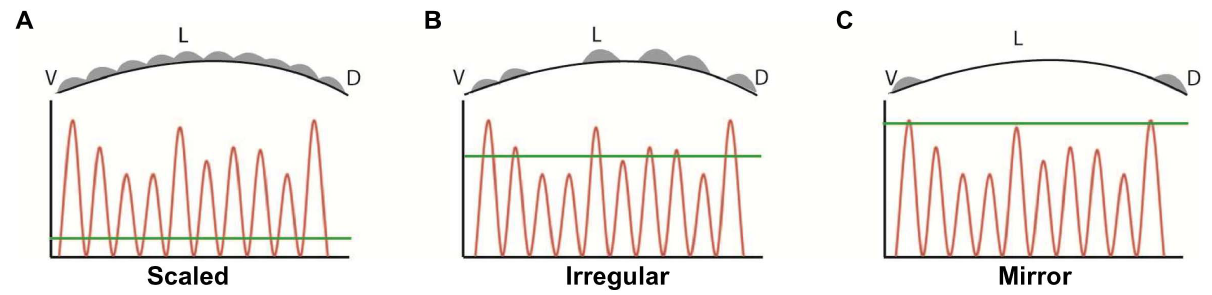
Figure 5. Our working hypothesis showing the rheostat-like action of mutations to the level of signals probably from multiple pathways. An uneven signal level at various locations combined with a gradually decreasing signal threshold in different allelic combinations (plus potential effect from additional modifier genes) might result in the scale pattern phenotypes described in the paper. An imaginary dorso-ventral cross-section shown in the top panel in each case (D: dorsal, L: lateral and V: ventral) shows the typical locations of preferential scale formation on the body surface while the green line indicates the threshold for variants of scaled (A), irregular (B), and mirror carps (C). (An alternate scenario for this hypothesis; stable threshold with decreasing signal intensity from scaled to nude would produce the same